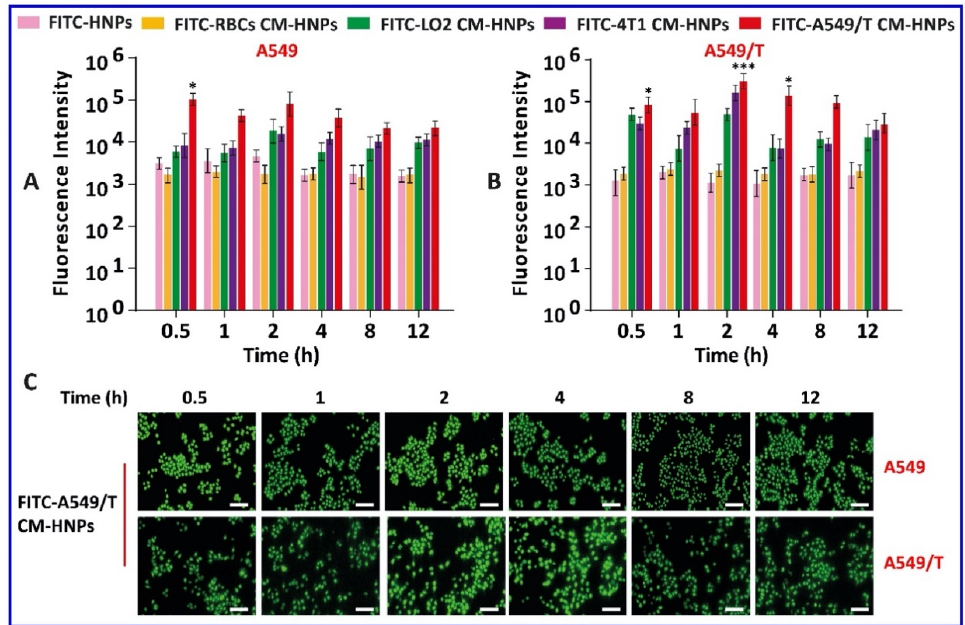
Figure 8. Cell uptake study. Flow cytometry analysis of cellular uptake of fluorescein 5(6)-isothiocyanate (FITC) HNPs in ( A ) A549 and ( B ) A549/T cells at a fixed FITC concentration of 50 ng/mL at 0.5, 1, 2, 4, 8, and 12 h. Microscopic images of ( C ) A549 and A549/T cells treated with FITC-A549/T CM-HNPs at a fixed FITC concentration of 50 ng/mL at 0.5, 1, 2, 4, 8, and 12 h. Scale bar: 100 μ m, * p < 0.05 and *** p < 0.001 vs. FITC-HNPs.